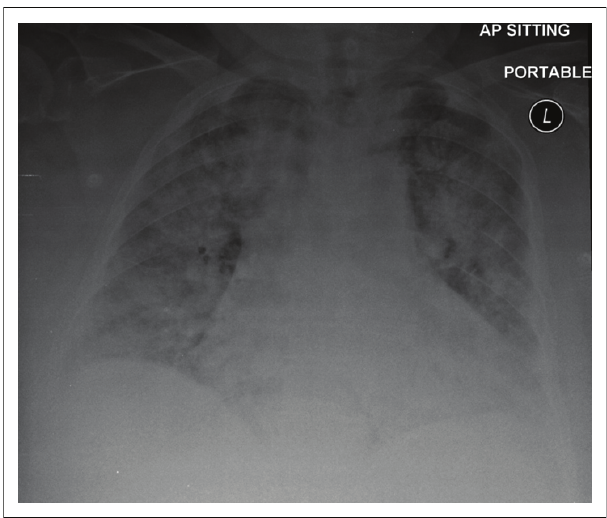
FIGURE 6: A 69-year-old female admitted to an isolation ward with COVID-19 pneumonia. Portable chest radiograph demonstrates air space opacification with no zonal predominance. Brixia score: 18.